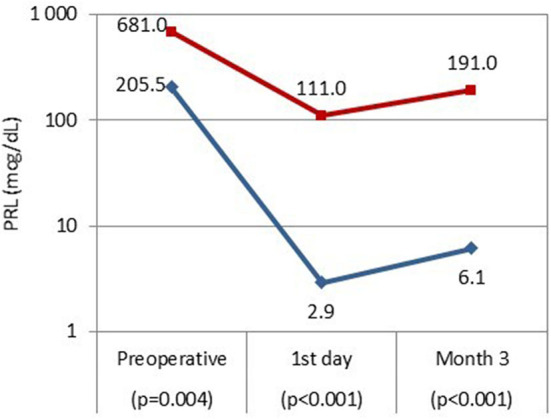
Serum prolactin concentrations before transsphenoidal surgery, on the 1st postoperative day and 3 months after surgery in patients with remission (blue line) and without remission (red line).